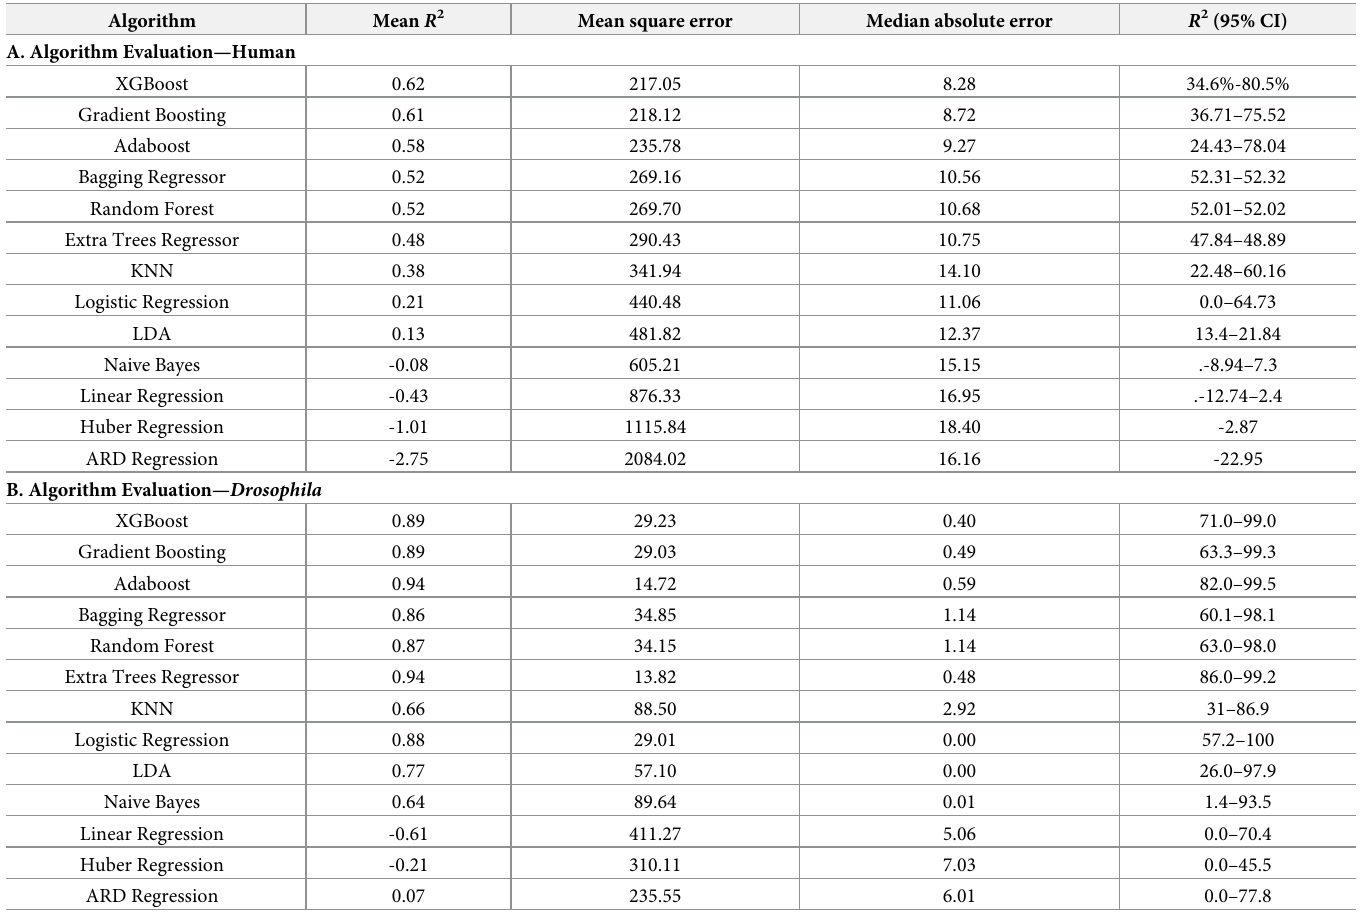
Table 2. Algorithm